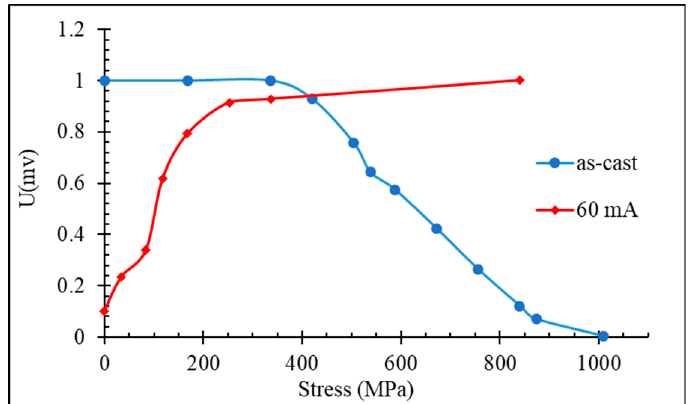
Figure 12. Effect of tensile stress on the amplitude of 11th harmonics of glass-coated amorphous Co 71 Fe 5 B 11 Si 10 Cr 3 microwires in an as-prepared state and after current annealing at 60 mA (122 A/mm 2 ) for 60 min (compare with the change in the hysteresis curves shown in Figure 7).